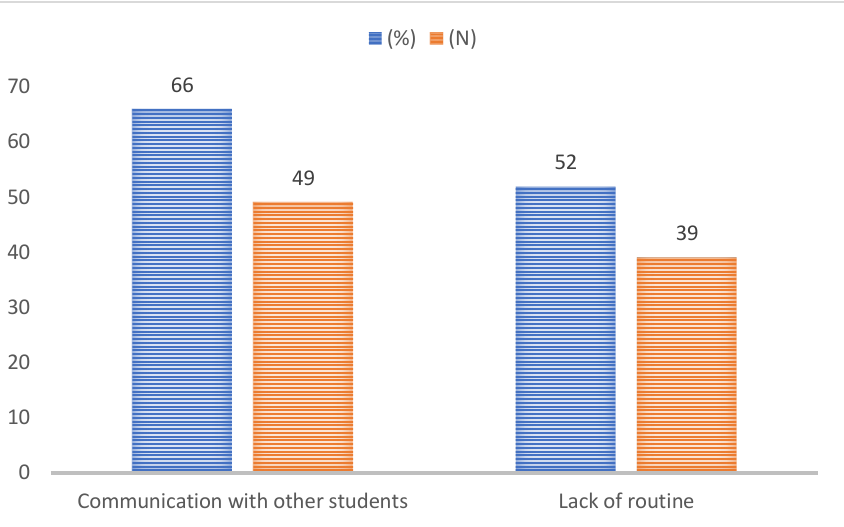
Figure 3. Consequences of the loss of contact with universities.